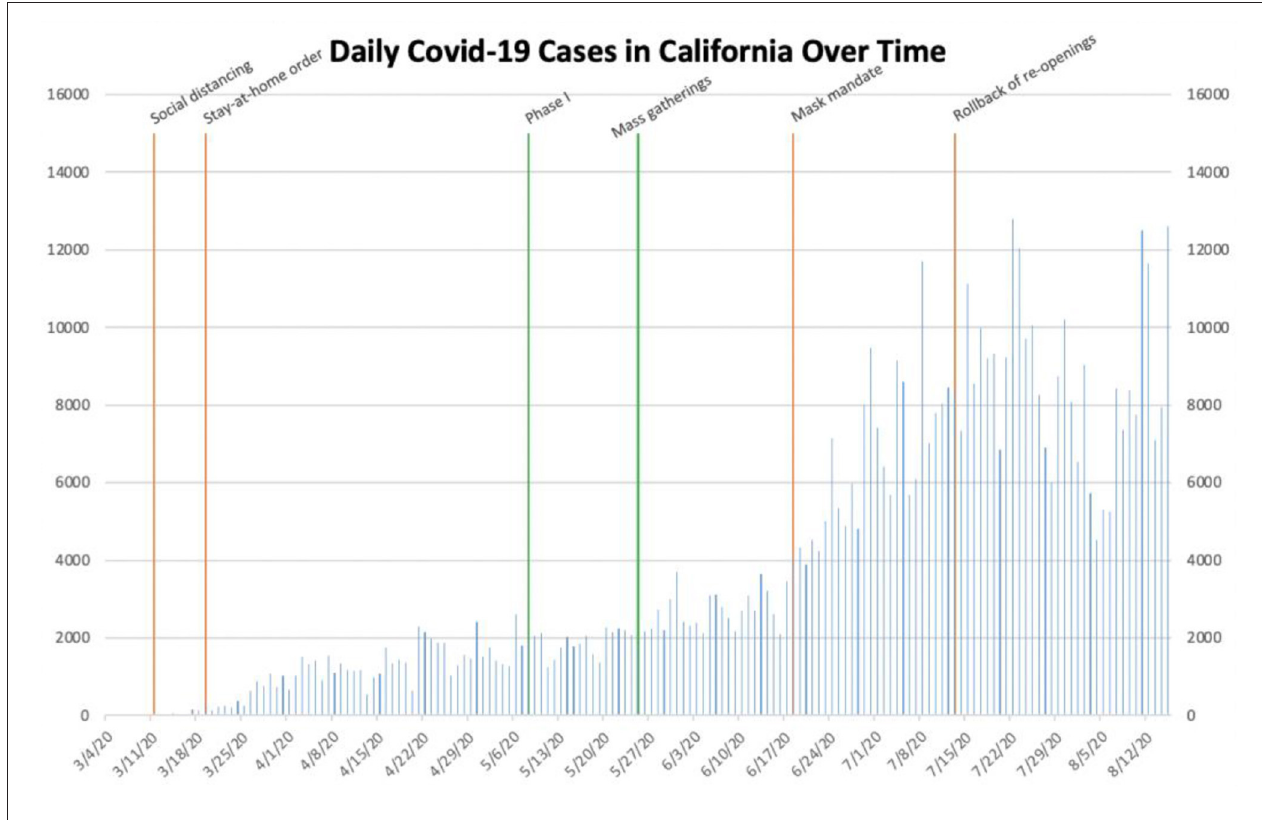
FIGURE 5 | Daily COVID-19 cases in